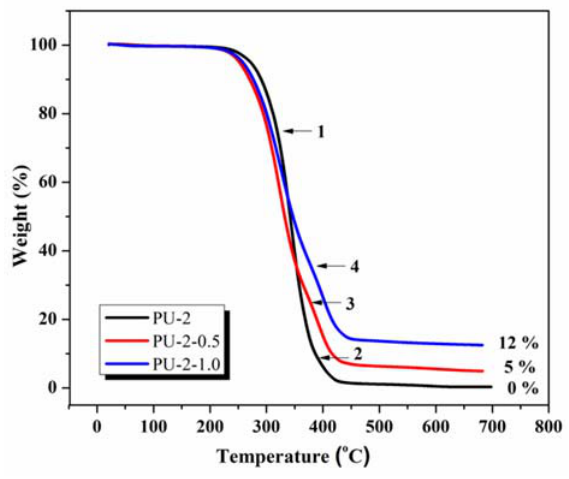
Figure 6. TGA thermograms for the neat PU-2 polyurethane and the corresponding composites PU-2-0.5 and PU-2-1.0.